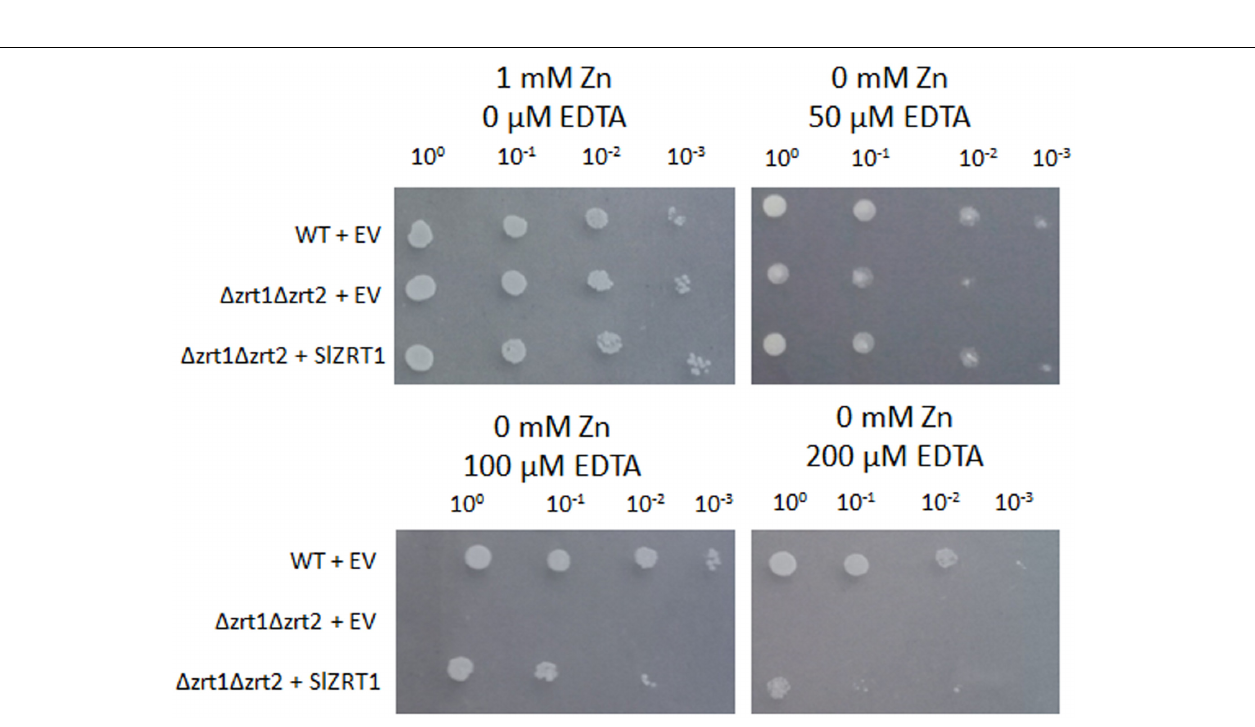
FIGURE 3 | Functional complementation of the zinc-uptake-deficient yeast strain (cid:49) zrt1 (cid:49) zrt2 by SlZRT1. Wild type (WT) and mutant yeast cultures with an OD 600 = 1 were 10-fold serial diluted (10 0 , 10 − 1 , 10 − 2 , and 10 − 3 ) and spotted on control (1 mM Zn) or ethylenediaminetetraacetic acid (EDTA) supplemented synthetic drop-out (SD) medium. The WT strain was transformed with the empty vector (EV, pYES-DEST52; Invitrogen), the mutant strain (cid:49) zrt1 (cid:49) zrt2 with either the EV or the vector containing SlZRT1 . The experiment was carried out for three independent clones and pictures were taken after 4 days of growth.